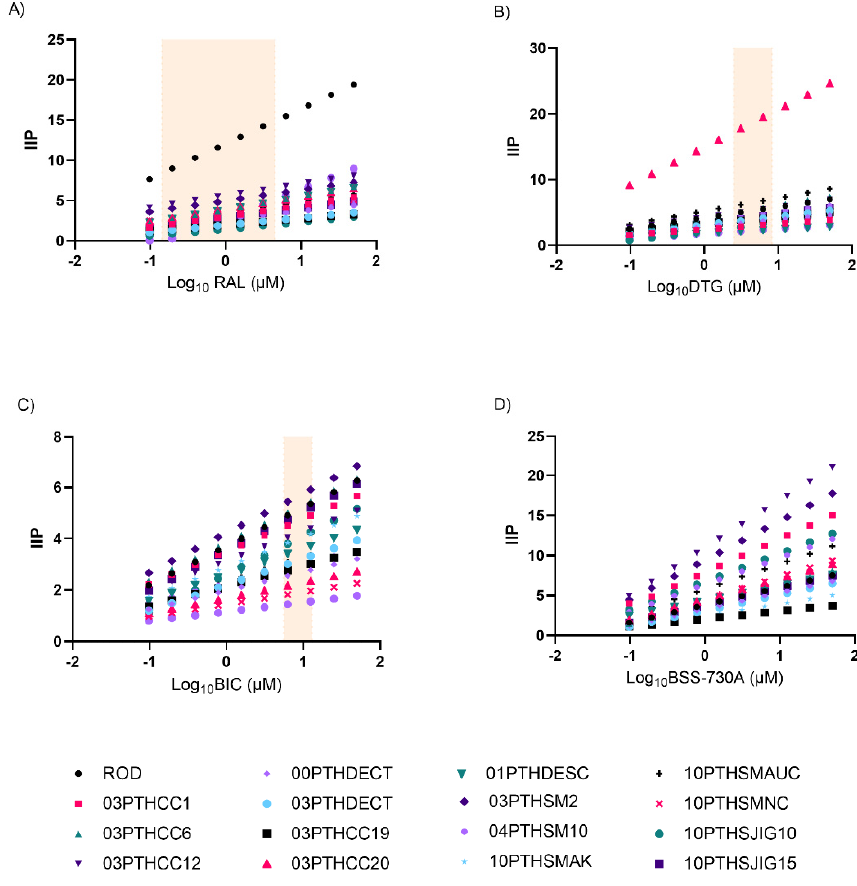
Figure 3. IIP values of RAL ( A ), DTG ( B ), BIC ( C ), and BSS-730A ( D ) for HIV-2 isolates at different concentration ranges. The rectangle limits the range of clinical concentrations, Cmax and Cmin, determined for each INI. Cmax and Cmin have not yet been defined for BSS-730A. Mean IIP values of BSS-730A at Cmax were significantly higher than RAL, DTG, and BIC (Figure 4; Supplementary Table S5). IIP values were similar for all INIs at Cmax and higher for DTG at Cmin.